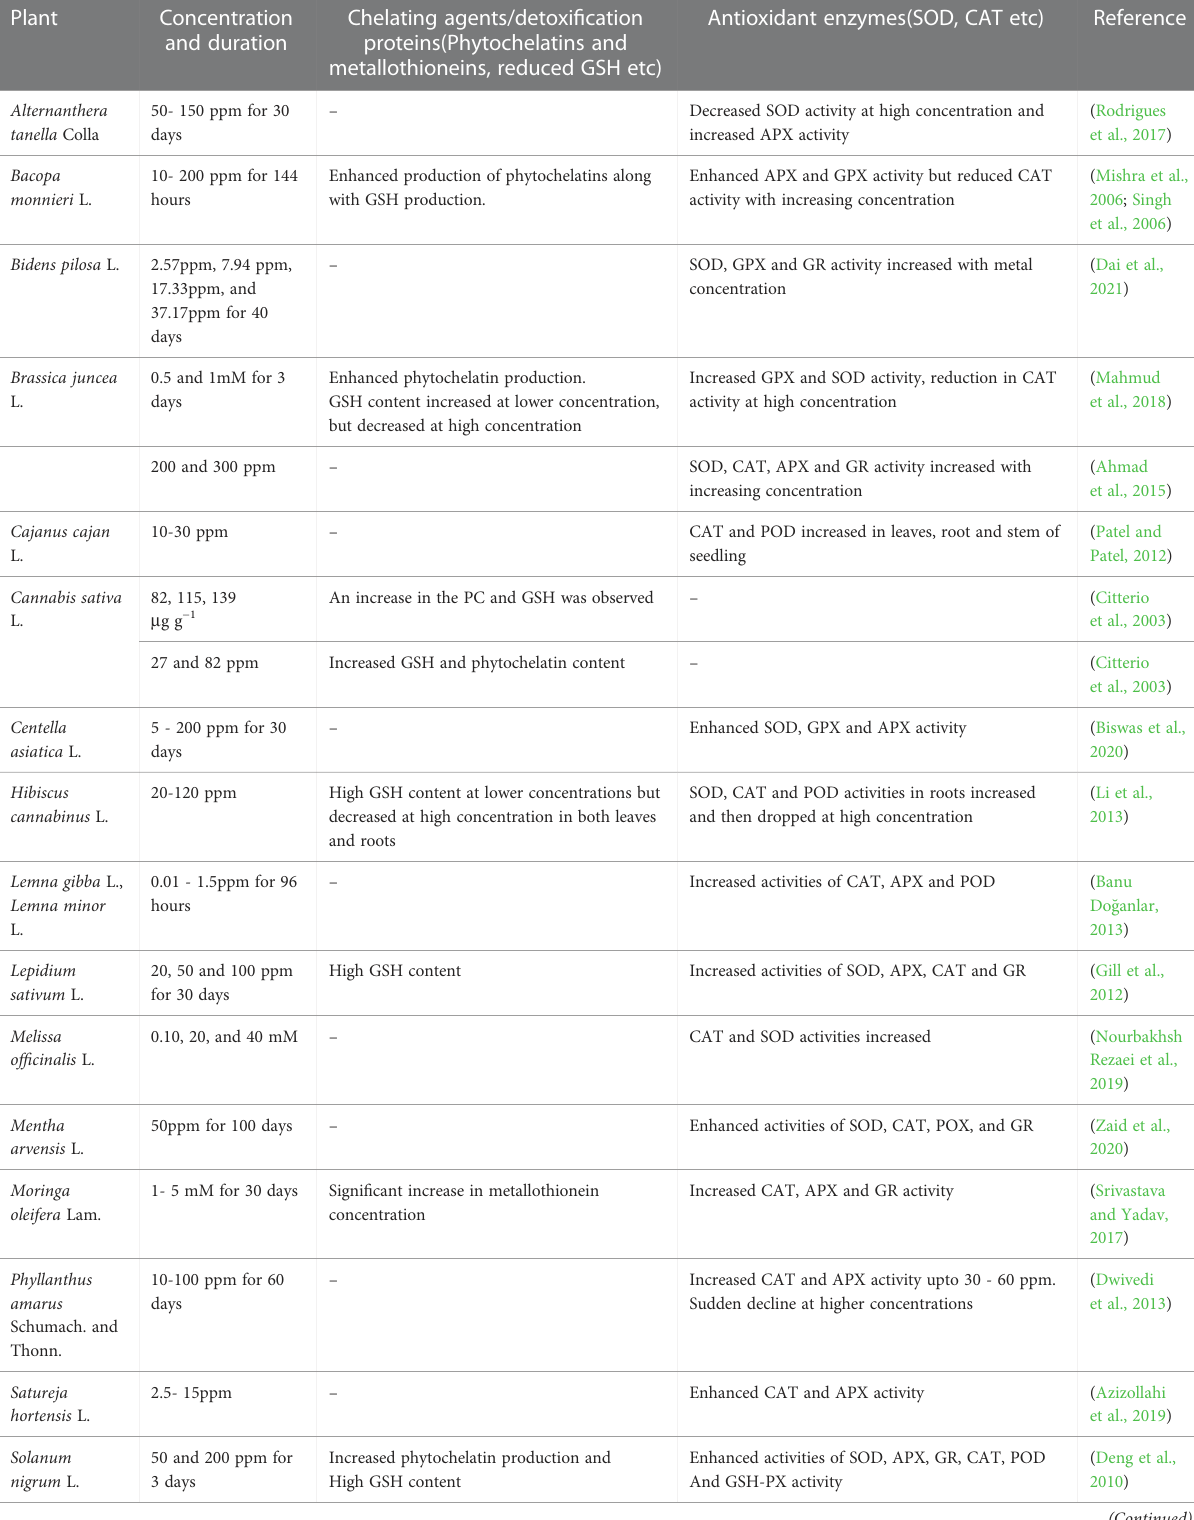
TABLE 5 Defense mechanisms for Cadmium tolerance in medicinal plants.